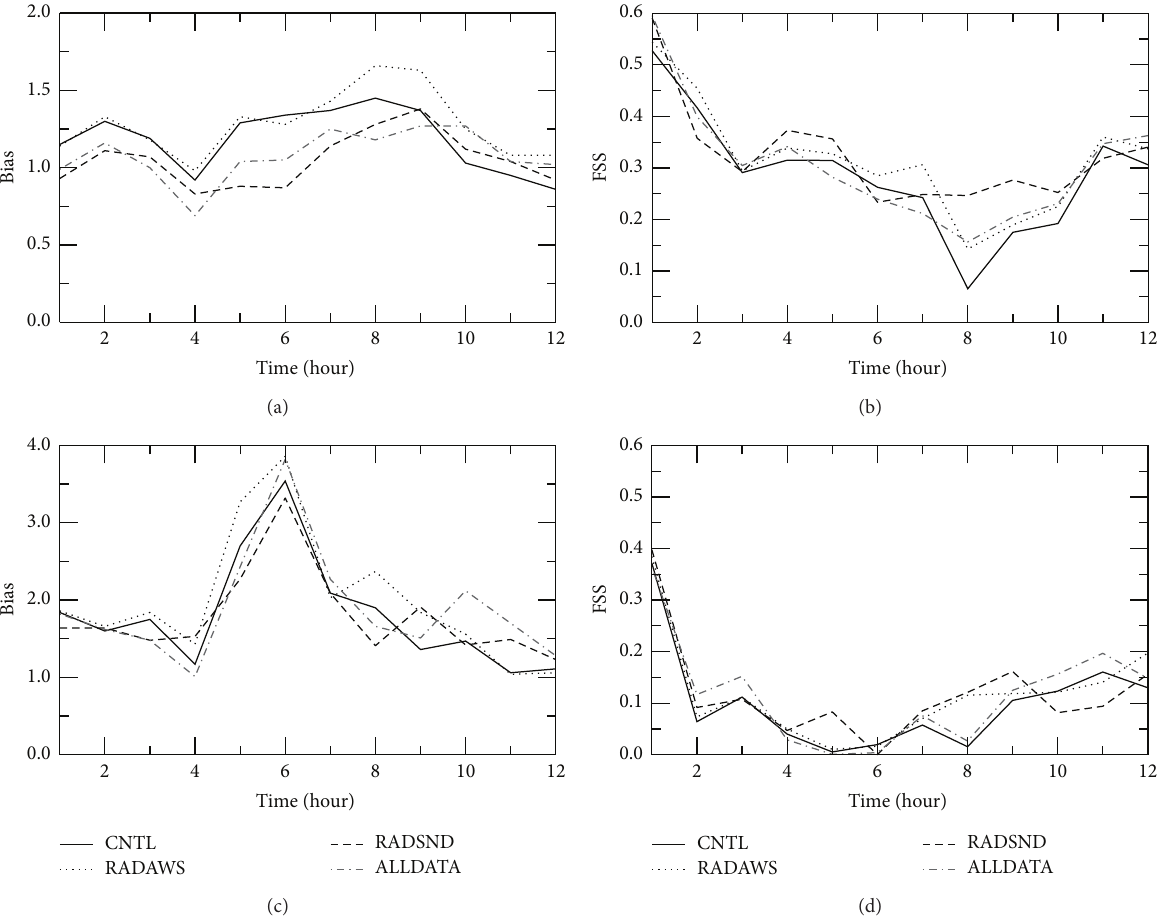
Figure 11: Bias score and FSS for hourly accumulated precipitation from experiments CNTL, RADAWS, RADSND, and ALLDATA for case 20110629. (a) Bias and (b) FSS with the threshold of 1mm and (c) bias and (d) FSS with the threshold of 5 mm.